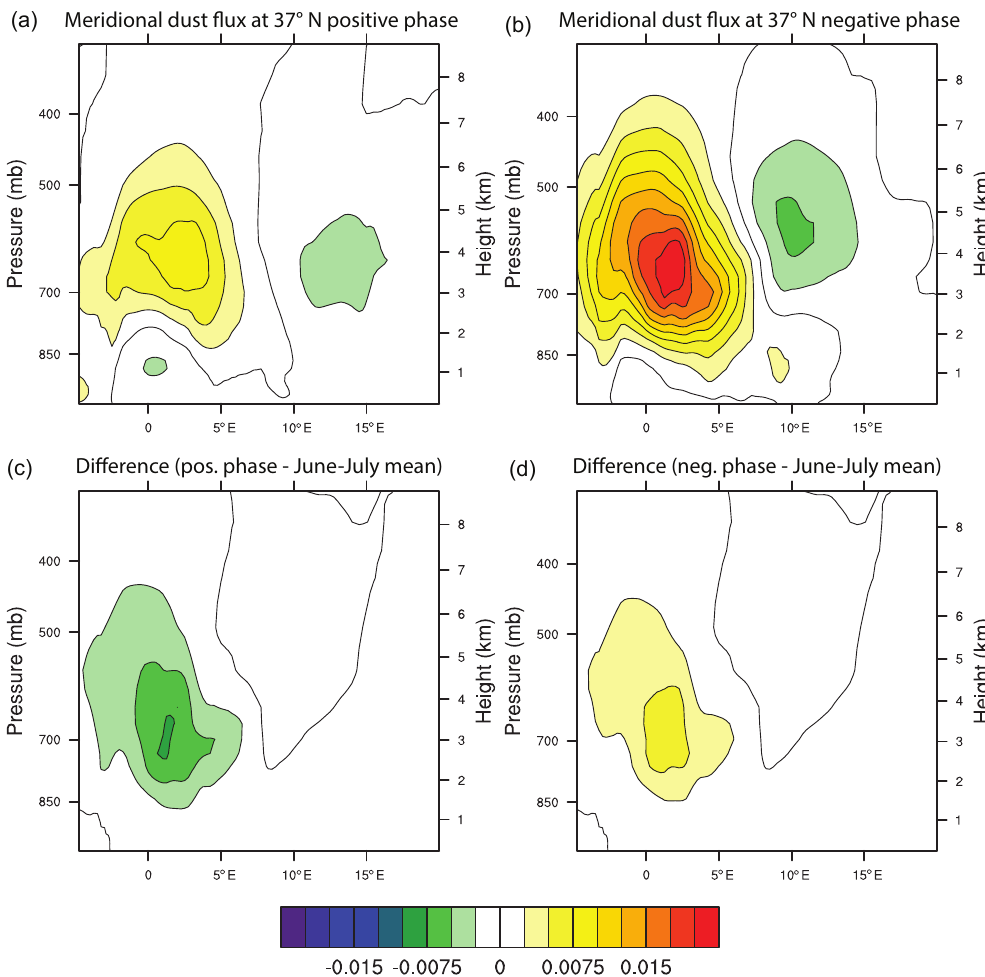
Figure 9. Composite of the meridional dust flux at 37 ◦ N (kgm − 2 d − 1 ) for positive (a) and negative (b) phases of the first EOF for June– July 2013. Panels (c) and (d) show the difference (kgm − 2 d − 1 ) regarding the June–July 2013